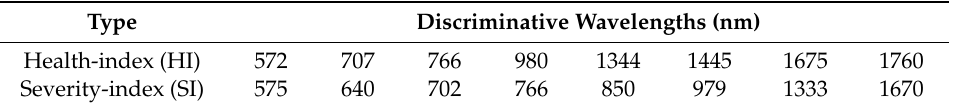
Table 3. Selected discriminative wavelengths for developing SCR-specific indices.